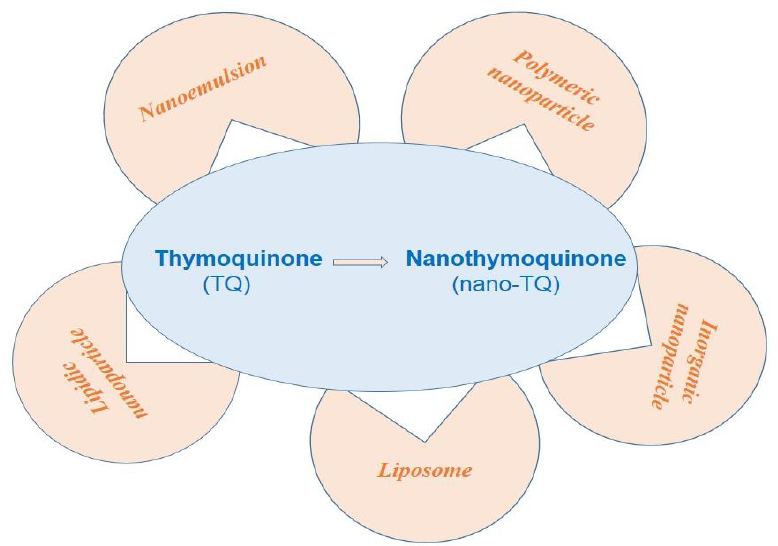
Figure 5. Various nanotechnology approaches improve the biopharmaceutical characteristics of TQ in the form of nano-TQ.